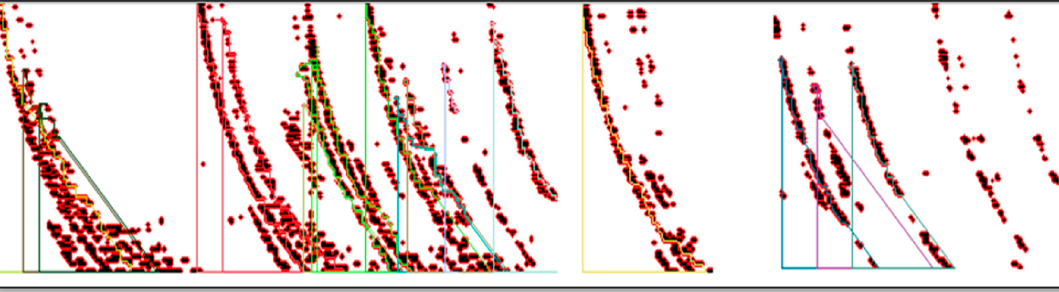
Figure 7. The result of the detected line and grouped as line-group.